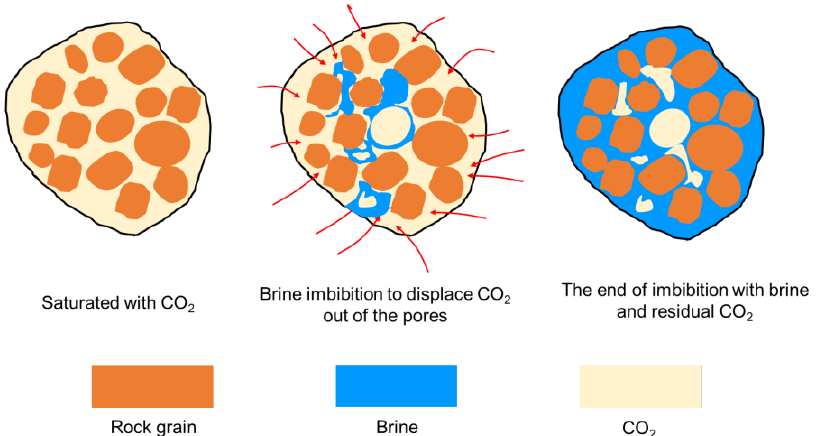
Figure 1. Schematic showing the CO 2 unstable storage due to two-phase CO 2 –brine imbibition processes where the pore space saturated with CO 2 (left) is flooded by brine, resulting in the displacement of in situ CO 2 out of the pores (middle), until finally only the residual CO 2 and brine are left in the pore space (right).